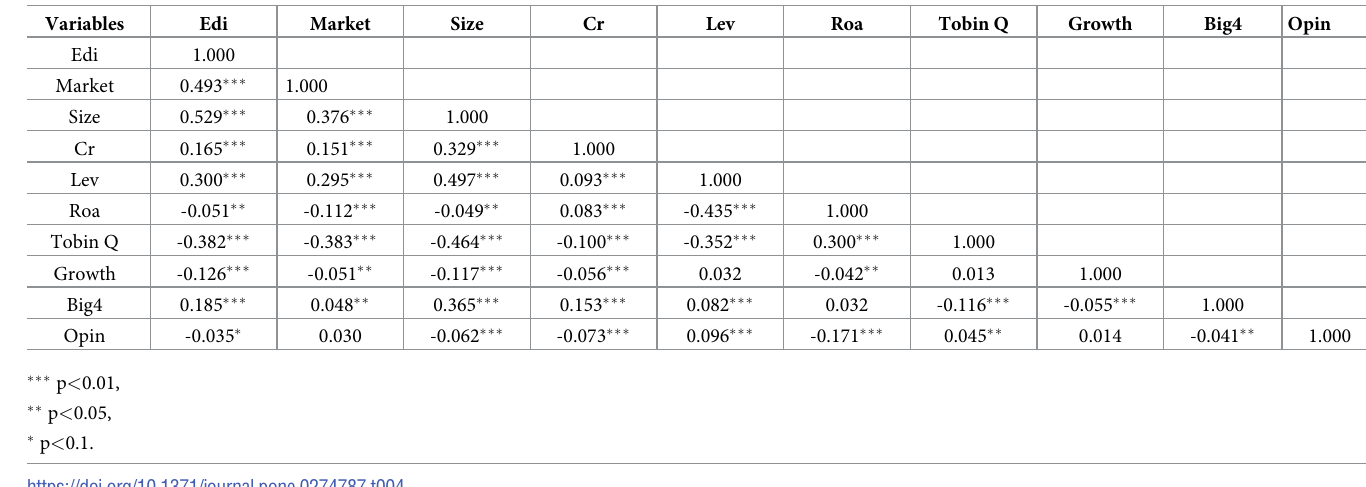
Table 4. Correlation